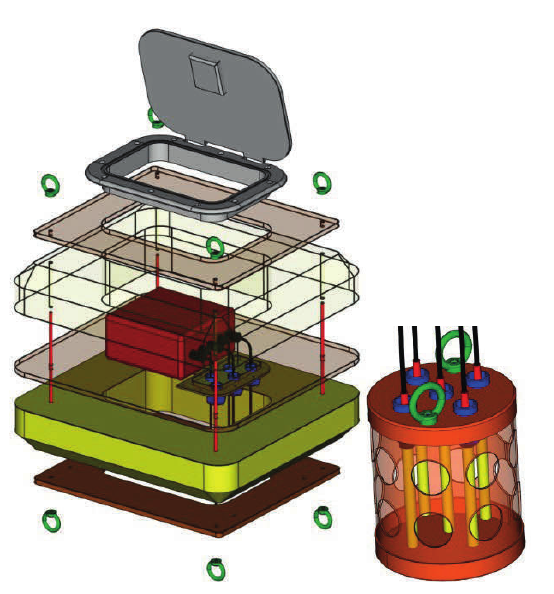
Fig. 3. Mechanical components: buoy construction and sensor protection cage.